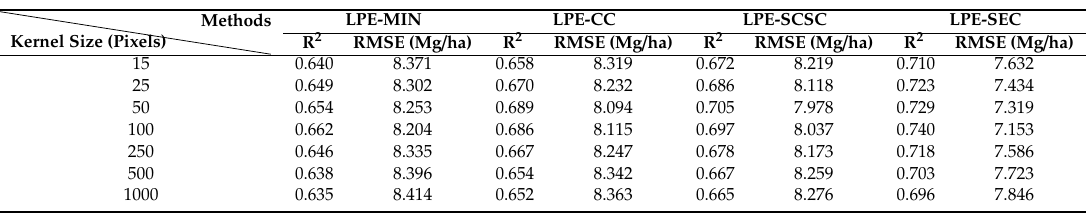
Table 4. The coe ffi cient of determination (R 2 ) and root mean square error (RMSE) of the forest carbon density predicted by the support vector regression (SVR) algorithm using the 30 m resolution Landsat 8 image corrected by TC models considering LPE with the kernel sizes ranging from 15 pixels to 1000